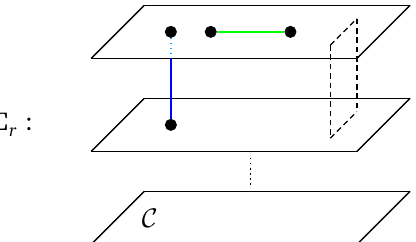
⊂ Y as a covering of the Gaiotto curve C . The dashed Figure 17: The N = 1 curve Σ r sheet denotes a branch cut connecting two sheets. The green and blue line segments denote 1-cycles wrapped by M2 branes and give rise to potential confining strings. The green cycle is contained in the M5 brane locus and is of the type depicted in figure 16. The confining strings associated to it are trivial and uncharged under the 1-form symmetry. The blue cycle stretches between the sheets, is contained in Y , and ( Y , Σ ) . These are charged under the is an element of the relative homology group H r 1 1-form